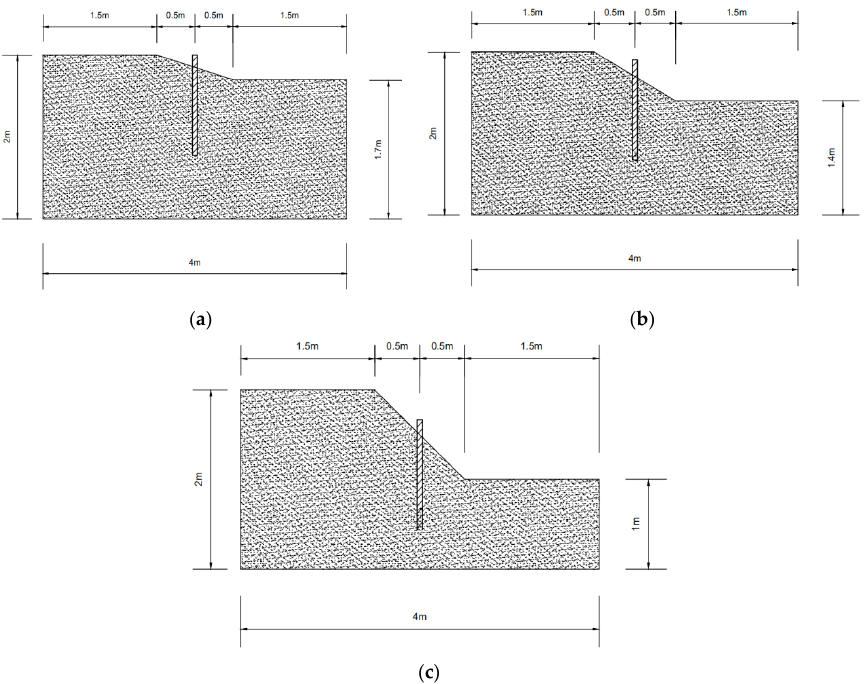
Figure 5. Sketch diagram of model with different slope angle (in meters): ( a ) 15° slope angle; ( b ) 30° slope angle; ( c ) 45° slope angle .